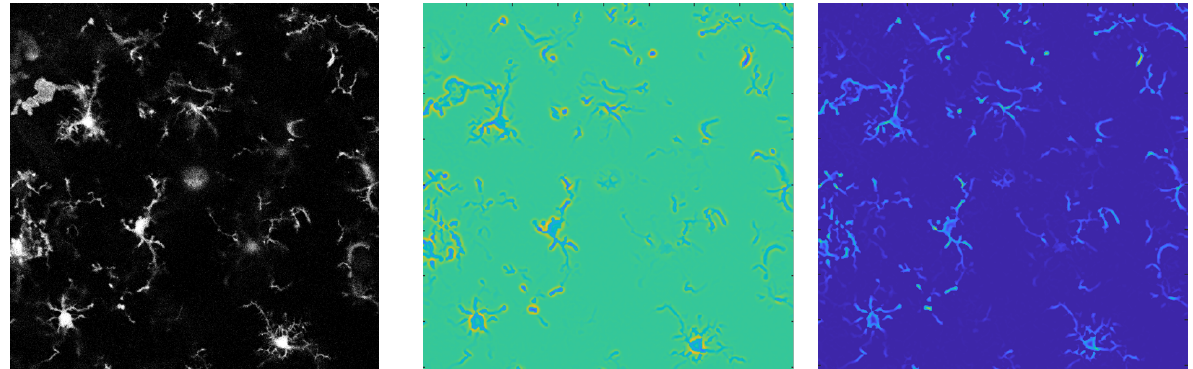
Figure 3. The initial seed points are determined using curvature analysis. The original image ( left ) is analyzed with a curvature analysis ( middle ) to find the foreground image ( right